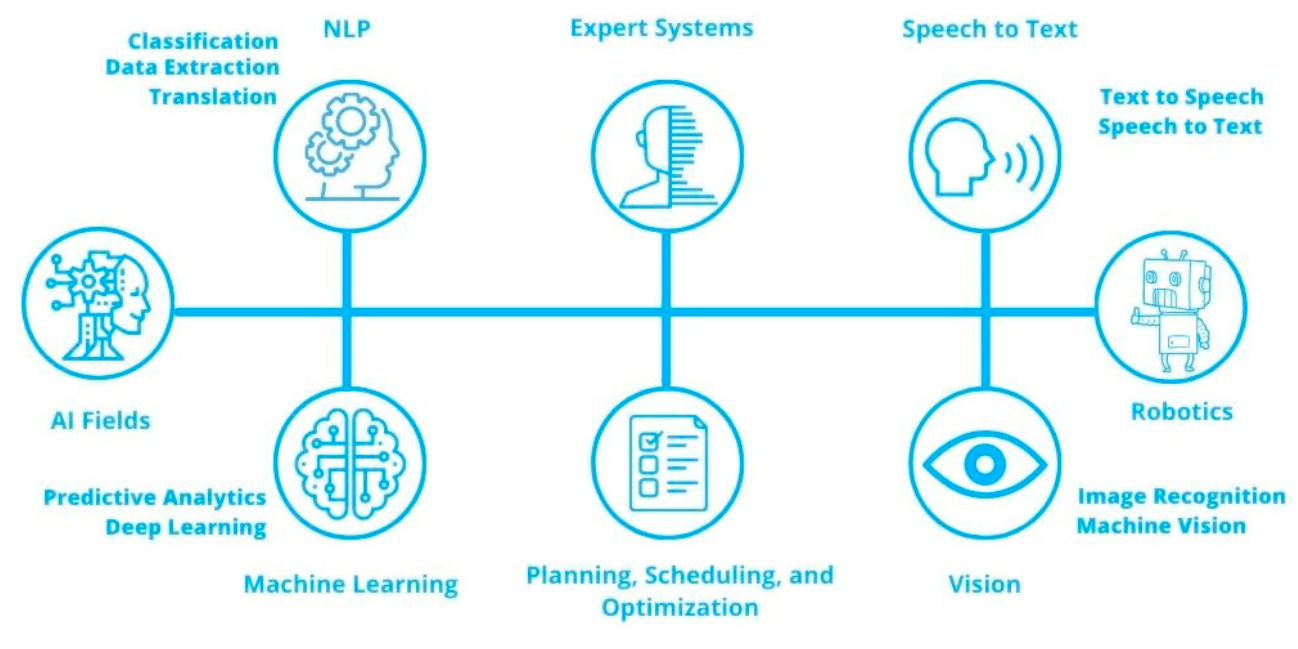
Figure 2. The seven fields of AI (Source: Authors).